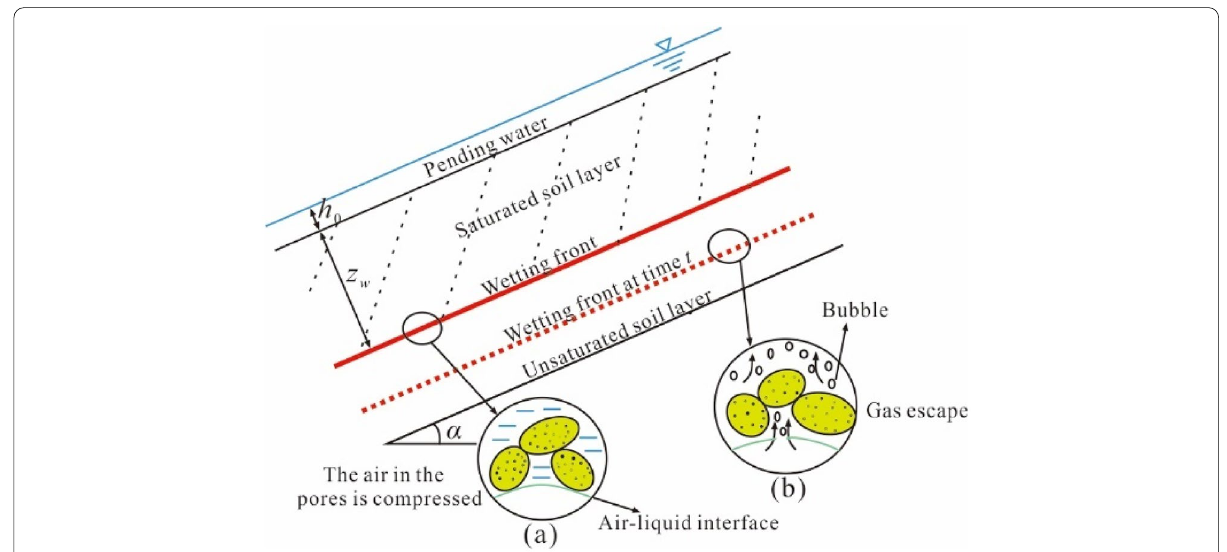
Fig. 1 Porous air compressed-escaped